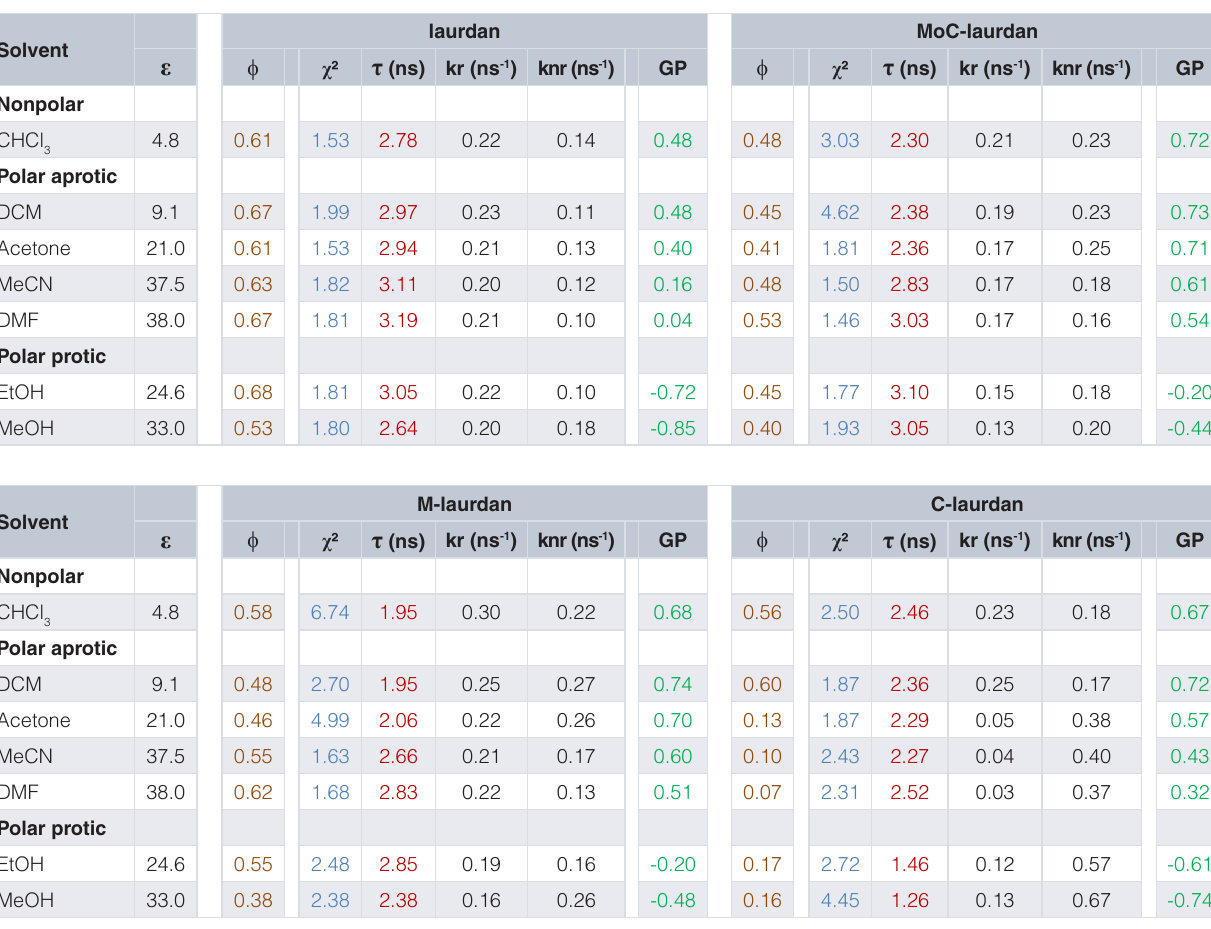
Table 2. Photophysical parameters of the dyes dissolved in pure solvents at a final concentration of 1 µM. ε refers to the solvent dielectric constant, quantum yields ϕ are measured using POPOP as reference ( ϕ POPOP=0.97 in cyclohexane), lifetimes τ are recorded at 460 nm (excitation, 380 nm) and reported along with the goodness of the fit χ 2 (POPOP was used as reference for deconvolution, τ POPOP=1.35 ns in ethanol), kr ( ϕ / τ ) and knr ((1- ϕ )/τ ) are the deexcitation constants deduced from quantum yields and lifetimes, Generalized Polarization, GP, are calculated from emission intensities at 440 and 490